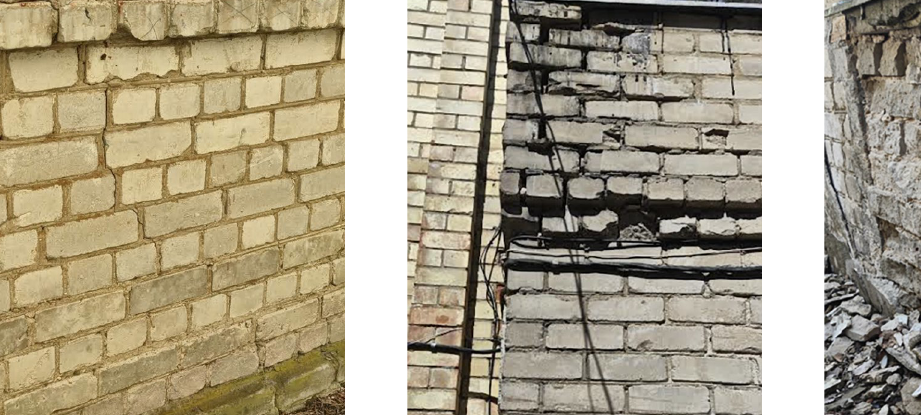
Figure 2. Defects in masonry walls due to inadequate drainage systems